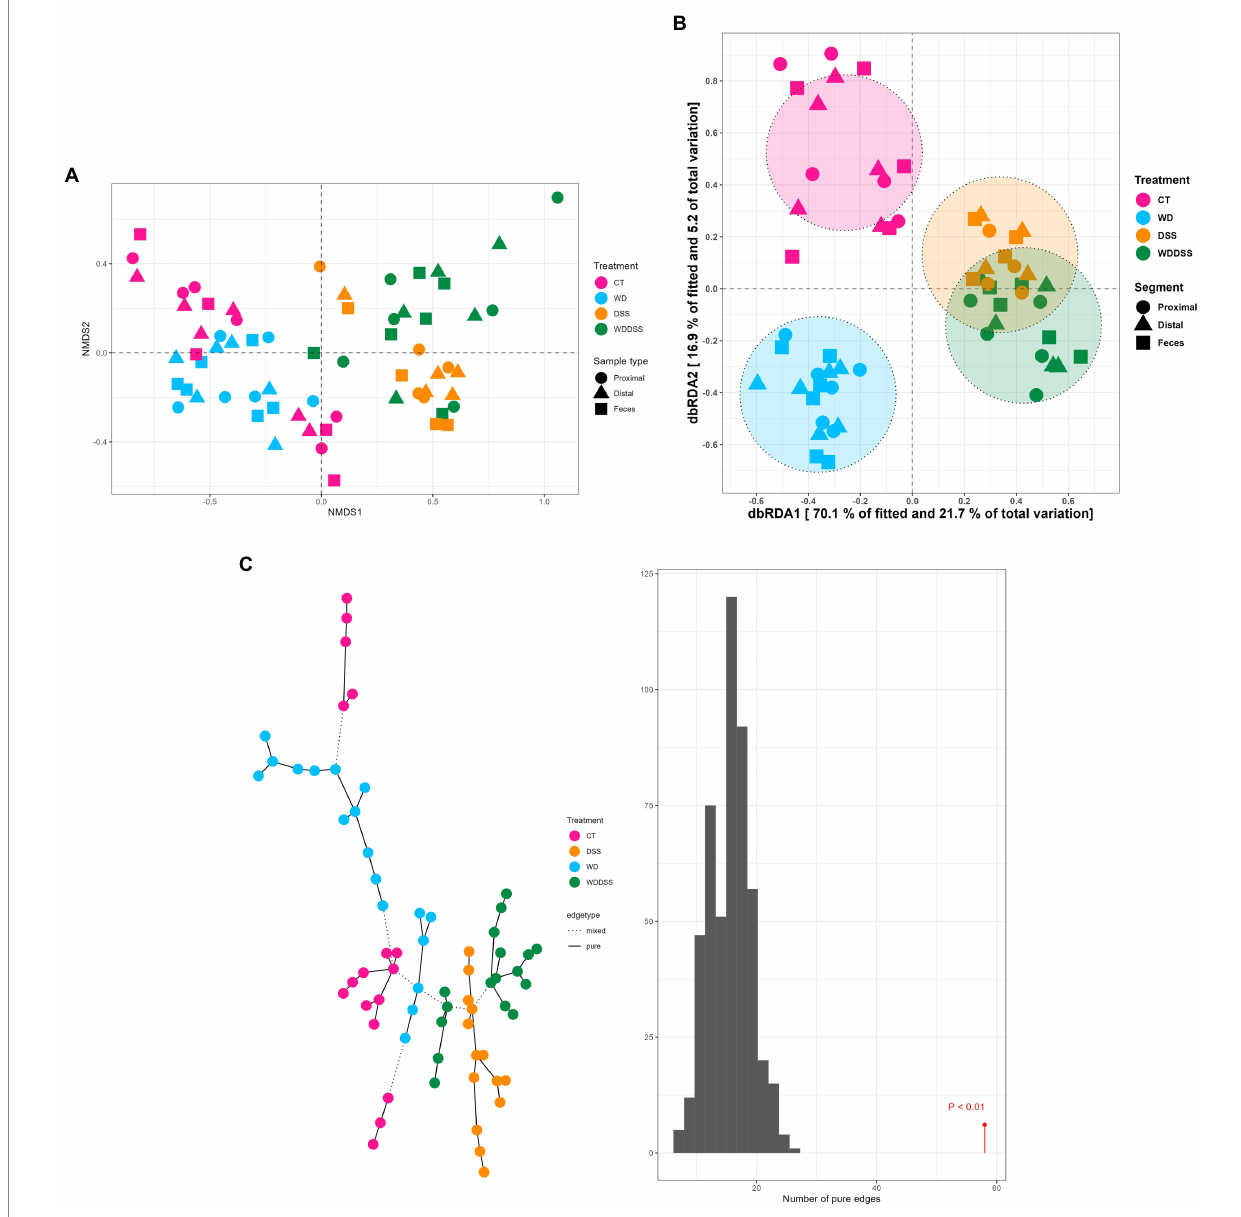
FIGURE 1 Non-metric multidimensional scaling (NMDS) plot based on Bray–Curtis dissimilarity index (A) , and dbRDA MDS plot (B) of sample scores from Bray– Curtis dissimilarity for different treatments (CT: control, WD: westernized diet, DSS: group treated with dextran sulfate sodium, and WDDSS: WD + DSS) extracted from dbRDA model (variance explained by our treatments = 31.0%, p < 0.01). On dbRDA plot, the treatments (constrained factors) explained 70.1 and 16.9% of the fitted variance and 21.7 and 5.20% of total variance for Bray–Curtis dissimilarity on dbRDA1 and dbRDA2 axis, respectively. The shape of the points represents the origin of the samples, i.e., digesta from proximal and distal colon, and fecal samples and the color of the points represent different treatments. Graph-based analysis of the distributions in bacterial composition for different treatments (C) , based on Bray–Curtis dissimilarity matrix with maximum distance of 0.35. The histogram of permutation test based on MST for Bray-Curtis is presented ( p <